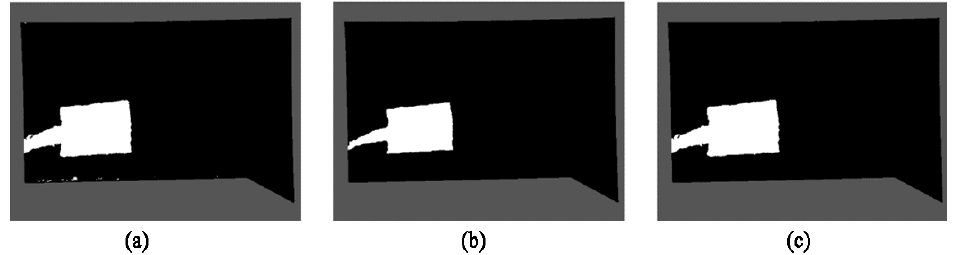
Figure 5. The detection result of the algorithm proposed in this paper: ( a ) Initial image of algorithm detection; ( b ) Morphological erosion image; ( c ) Morphological reconstruction